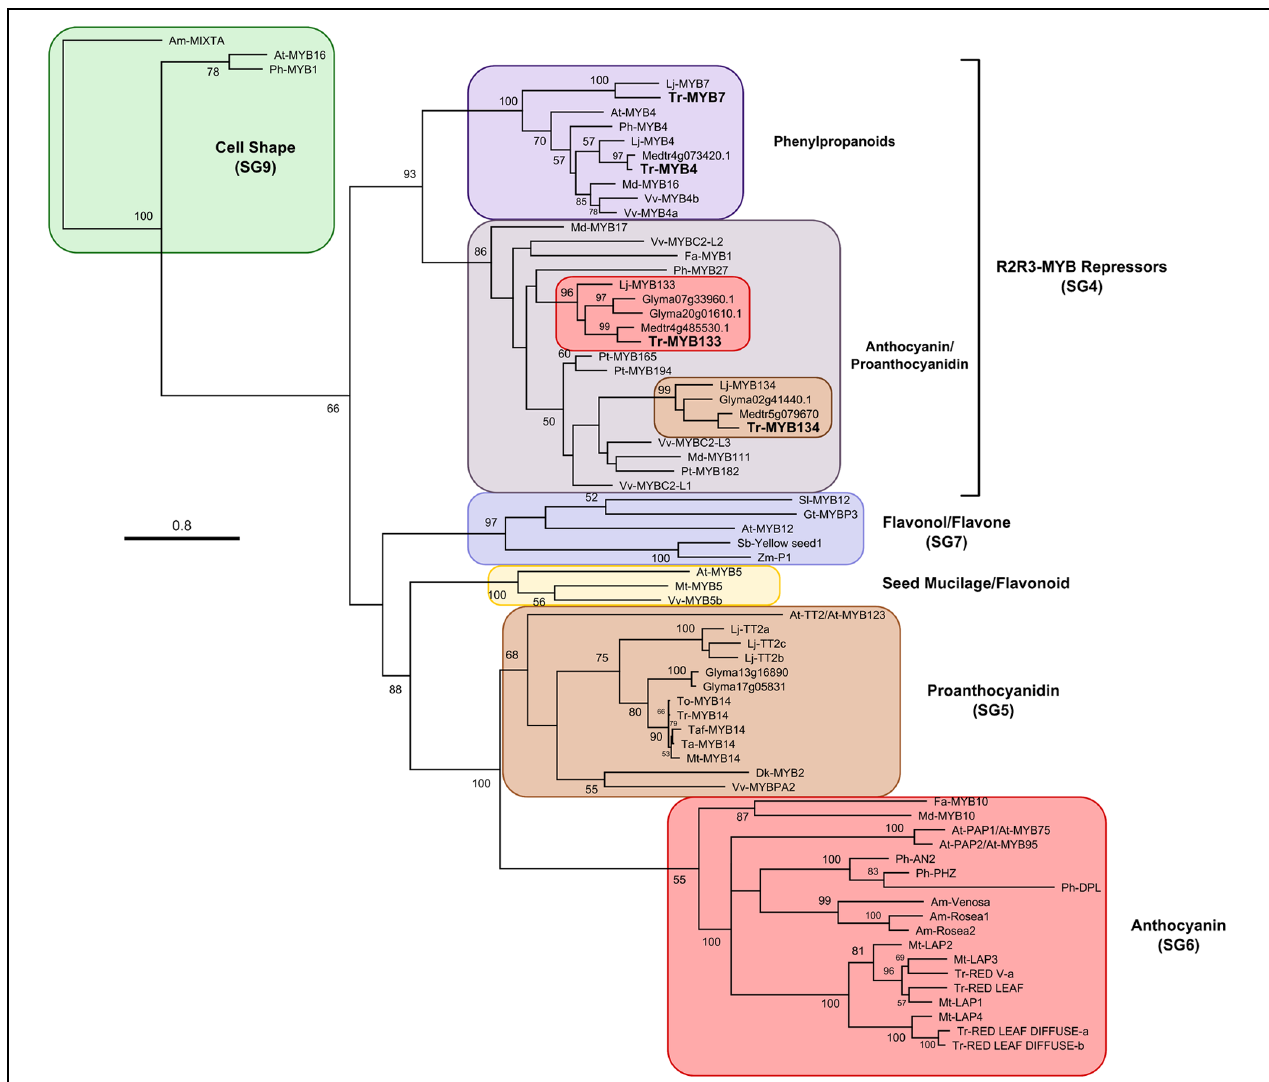
FIGURE 1 | Maximum likelihood phylogenetic tree of R2R3-MYB proteins. Nodes with bootstrap support > 50% from 1000 replicates are shown. Accession numbers for sequences used to construct this tree are provided in Supplementary Table S2. At, Arabidopsis thaliana; Am, Antirrhinum majus; Fa, Fragaria ananassa; Gt, Gentiana triflora; Gm, Glycine max; Lj, Lotus japonicus; Md, Malus domestica; Mt, Medicago truncatula; Ph, Petunia hybrida; Pt, Populus trichocarpa; Sl, Solanum lycopersicum; Ta, Trifolium arvense; Taf, T. affine; Tr, T. repens; To, T. occidentale; Vv, Vitis